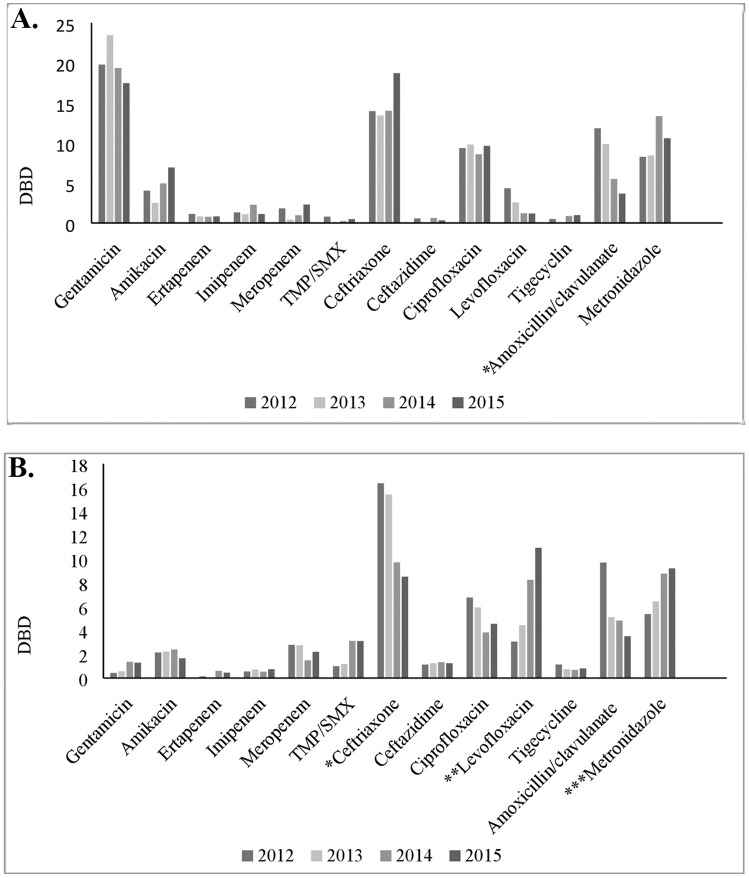
Trends of antibiotic consumption by individual drugs on surgical (A) and medical (B) wards from 2012 to 2015.A. *There was a statistically significant decrease in the use of amoxicillin/clavulanate (b = -2.881; p = 0.014). B. *There was a statistically significant decrease in the use of ceftriaxone (b = -2.925; p = 0.047). **There was a statistically significant increase in the use of levofloxacin (b = 2.745; p = 0.014). ***There was a statistically significant increase in the use of metronidazole (b = 1.385; p = 0.029).